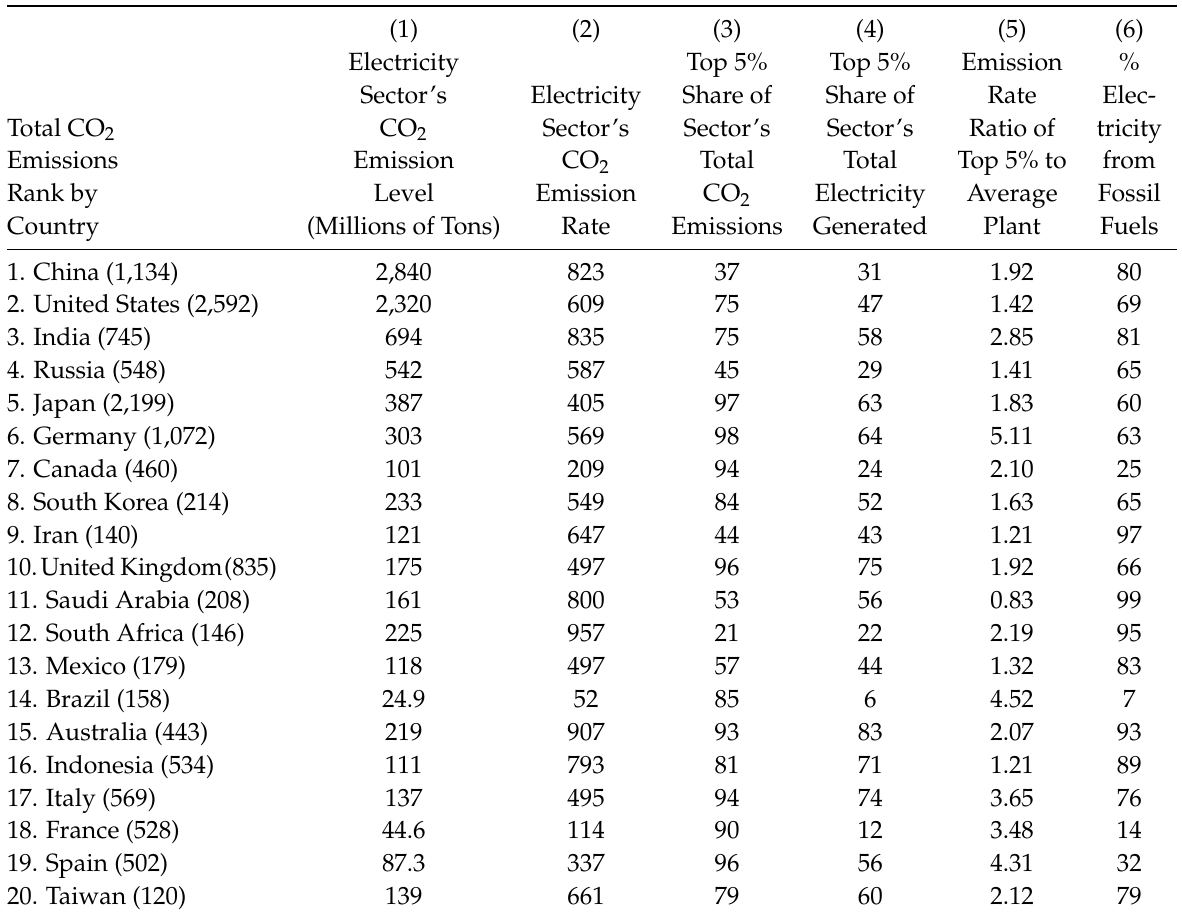
Table 1: Top CO 2 -emitting countries